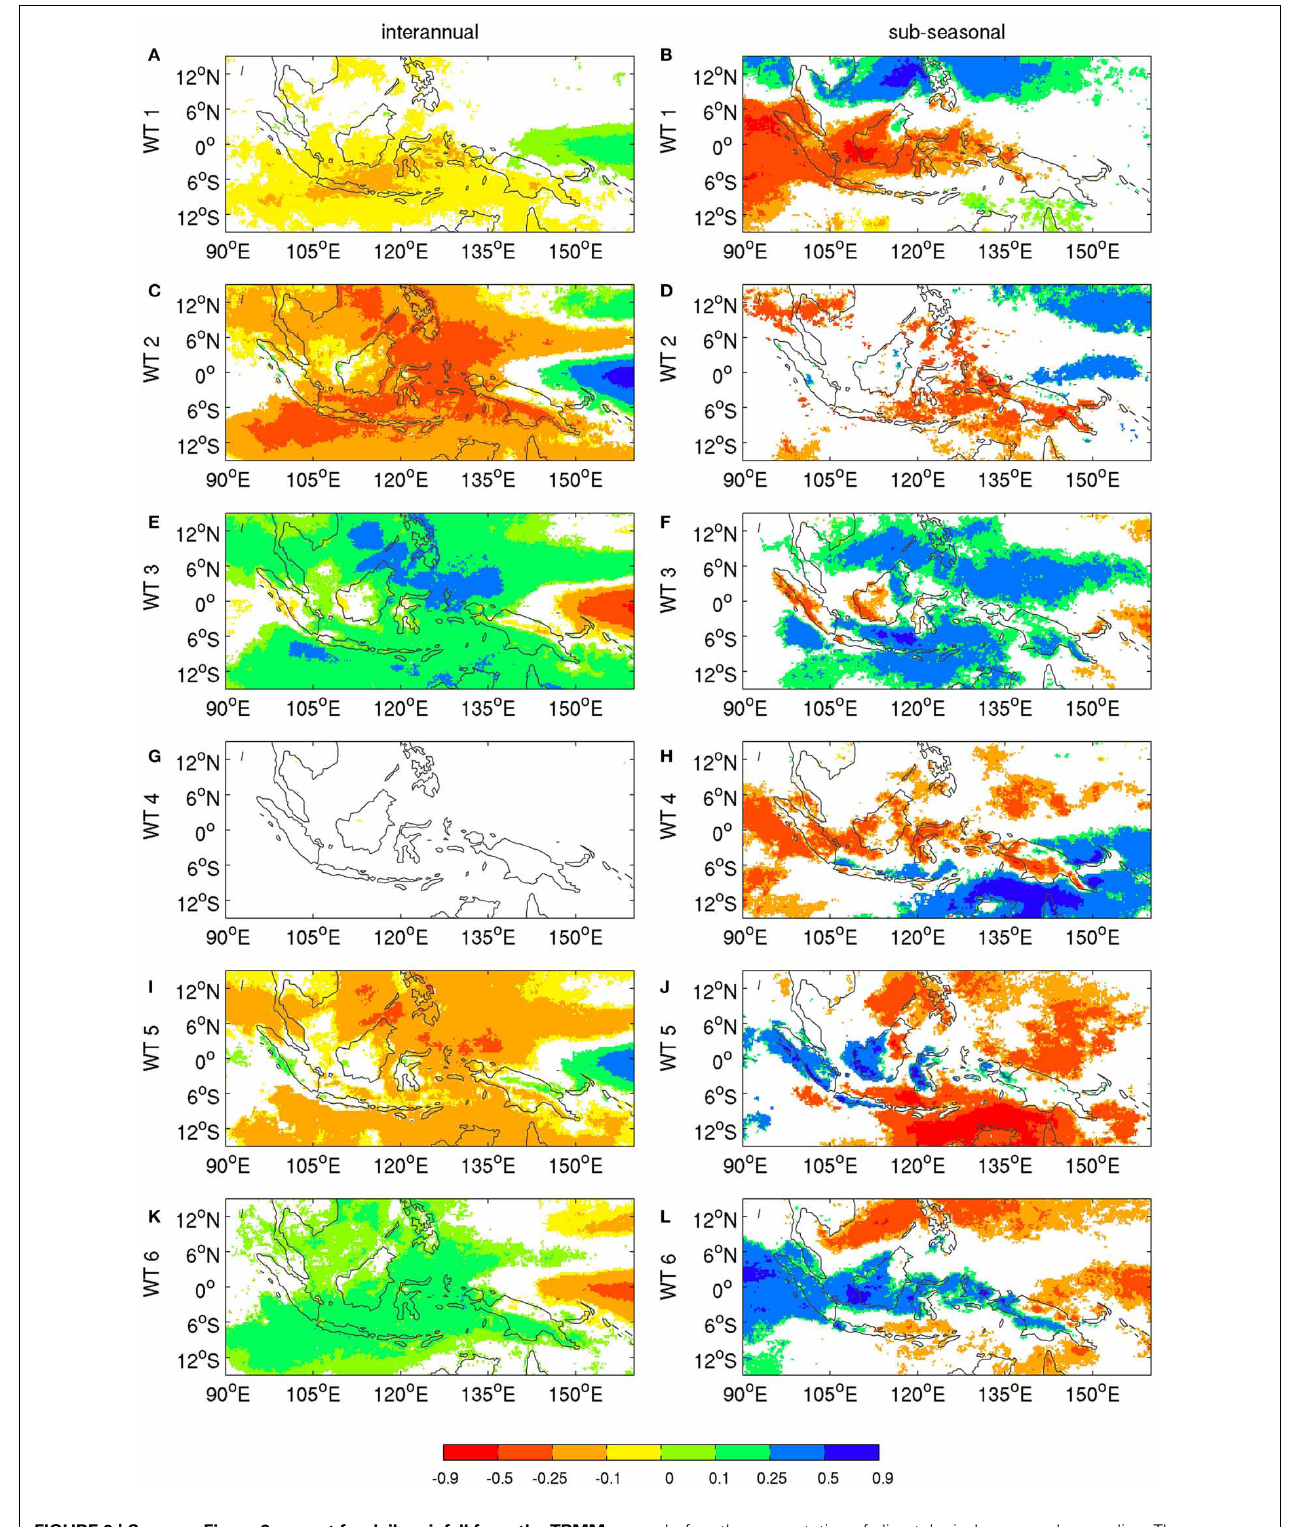
FIGURE 9 | Same as Figure 8, except for daily rainfall from the TRMM 3b42 (version 7) dataset (Huffman et al., 2007). Rainfall data are available from 1998/1999 on only. Daily rainfall (in 1 / 10mm/day) are cube rooted